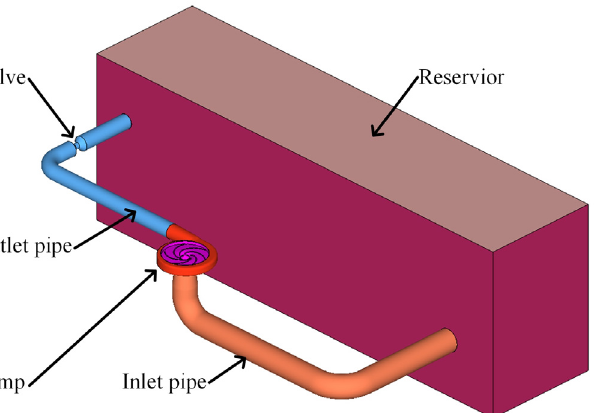
Fig. 2. Semi-closed simulation model of centrifugal pump piping system.